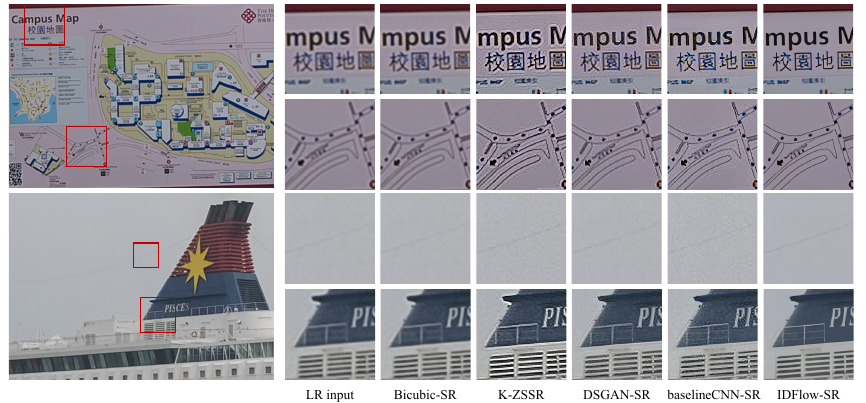
Figure 6. Visual comparisons of SR models on images “Nikon040” and “Nikon017” with a scale factor of 4 × . Local regions of the results are cropped and zoomed for a better visual comparison.